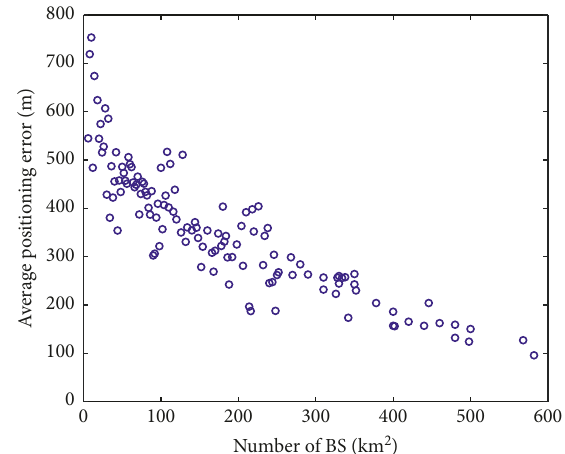
Figure 11: Average positioning errors of mobile phone data under different BS densities.